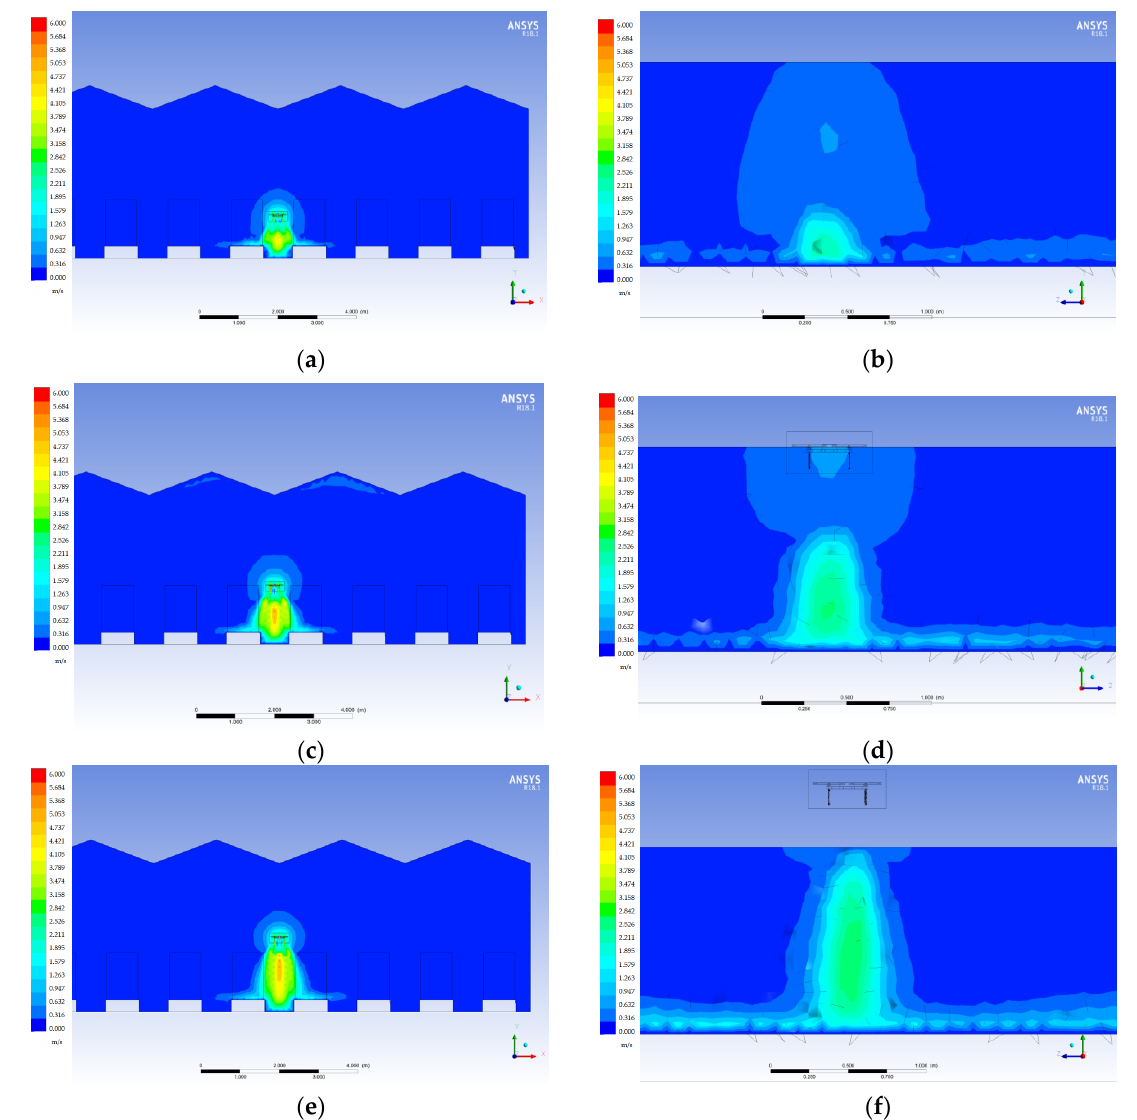
Figure 10. Velocity contour; ( a ) Y = 1.1 m X–Y; ( b ) Y = 1.1 m crop section; ( c ) Y = 1.5 m X–Y; ( d ) Y = 1.5 m crop section; ( e ) Y = 1.9 m X–Y; ( f ) Y = 1.9 m crop section.